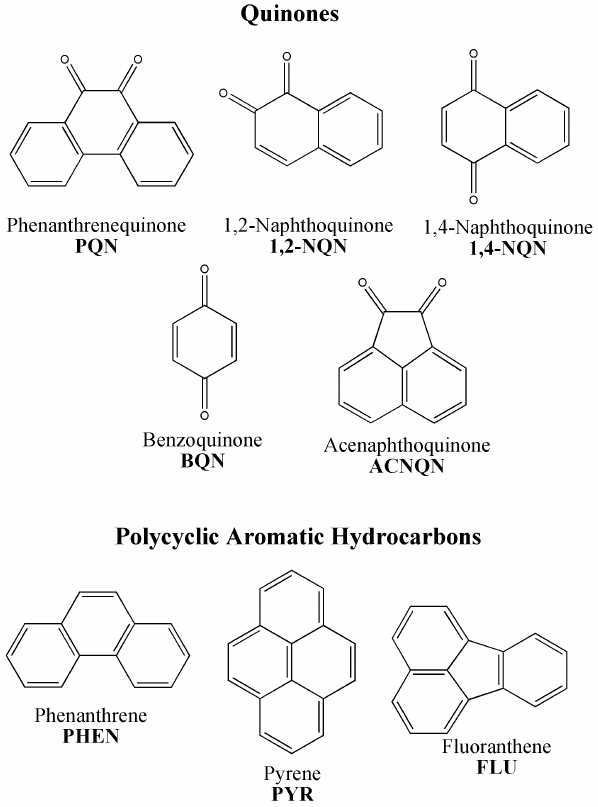
Fig. 1. Chemical structures and abbreviations for the quinones and polycyclic aromatic hydrocarbons tested for DTT activity.